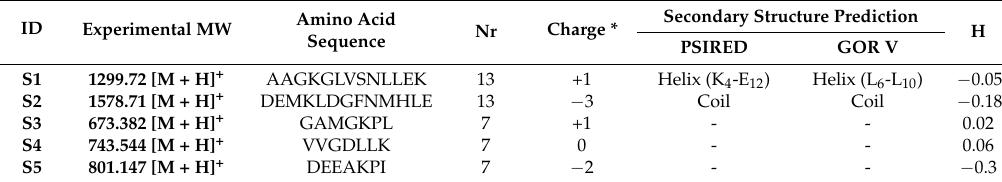
Table 1. Sequences identified by ESI-MS-MS in fraction 4 of of L. latrans obtained by SE.